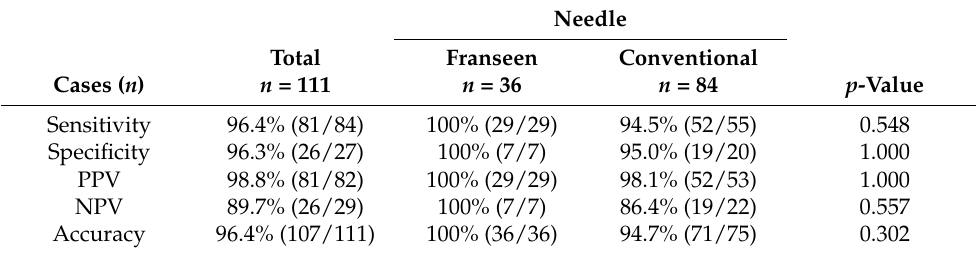
Table 5. Diagnostic ability of EUS-FNA for SELs compared with Franseen and conventional needles ( n =